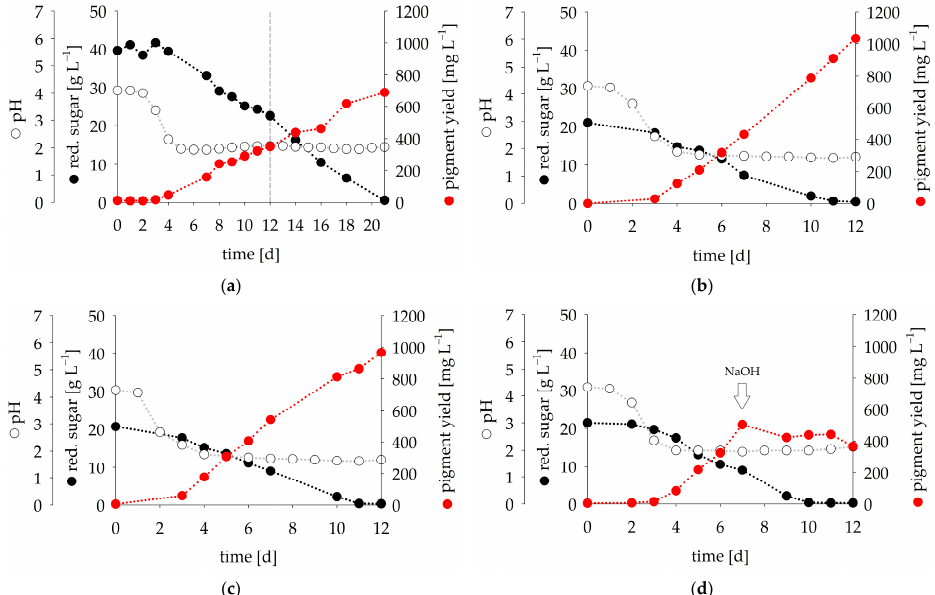
Figure 2. Influence of different media and pH regulation on laetiporic acid yield during cultivation in a 7 L STR. ( a ) Moser b, dashed line marks day 12; ( b ) PDB; ( c ) PDB + 5 g L − 1 beech sawdust; ( d ) PDB + pH regulation.